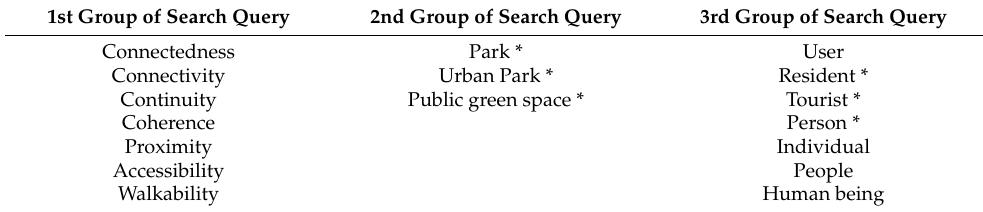
Table 1. Key search query.